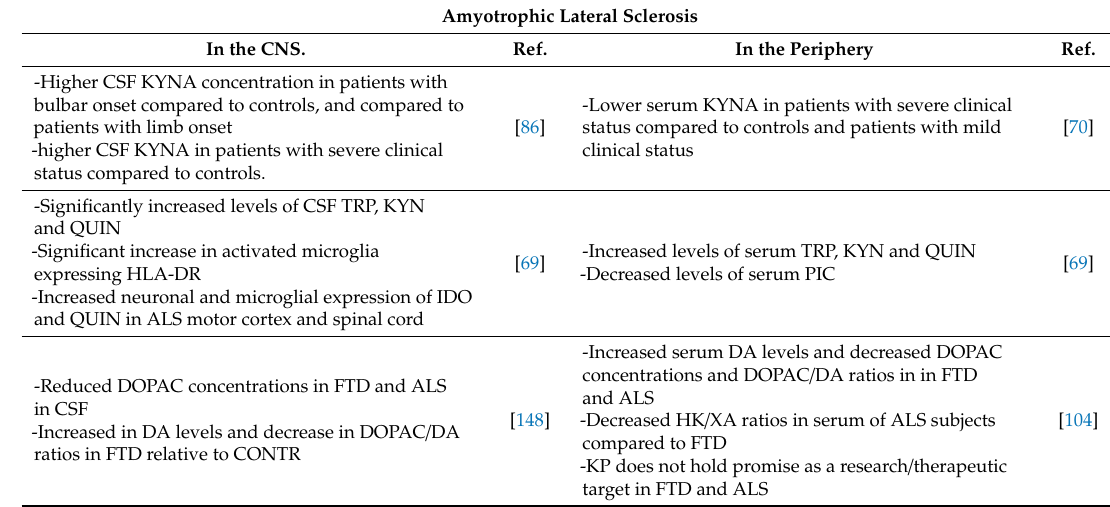
Table A3. Di ff erences of kynurenine pathways in the CNS and the periphery in amyotrophic lateral sclerosis.